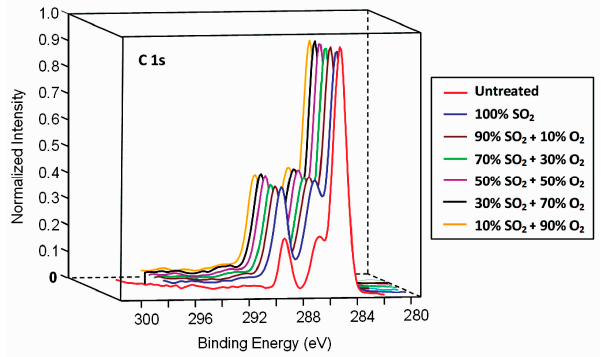
Figure 5. High-resolution C1s peak for samples treated at various SO 2 + O 2 mixtures.